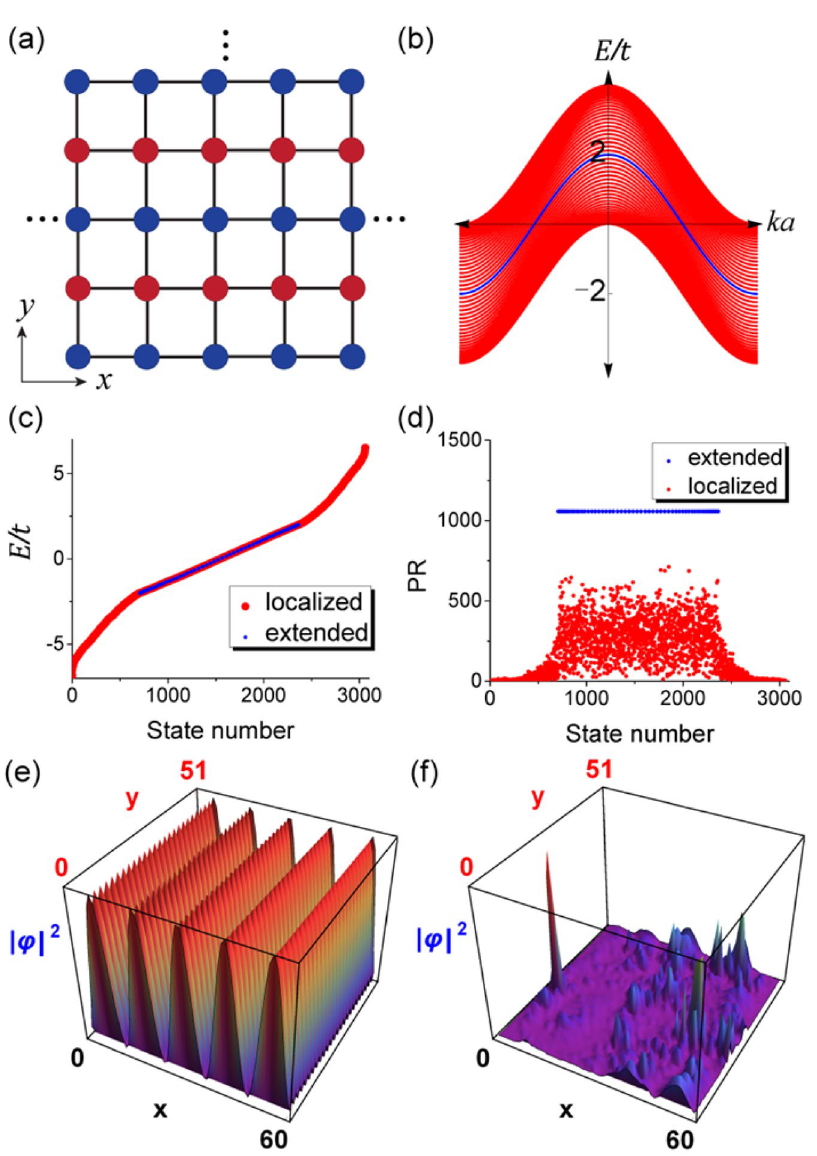
Figure 1. ( a ) A square lattice comprising multiple chains extending in the x direction. ( b ) The band structure with one band in blue color characterized by the same dispersion relation as that of an isolated chain. ( c ) The energy spectrum showing the spectral coexistence of extended states and localized states in the presence of onsite disorder on alternating chains (i.e. red sites). ( d ) The participation ratios of all the eigenstates. ( e ) and ( f ) show two states with the same eigen-energy E / t = 1.93, one is extended and the other is